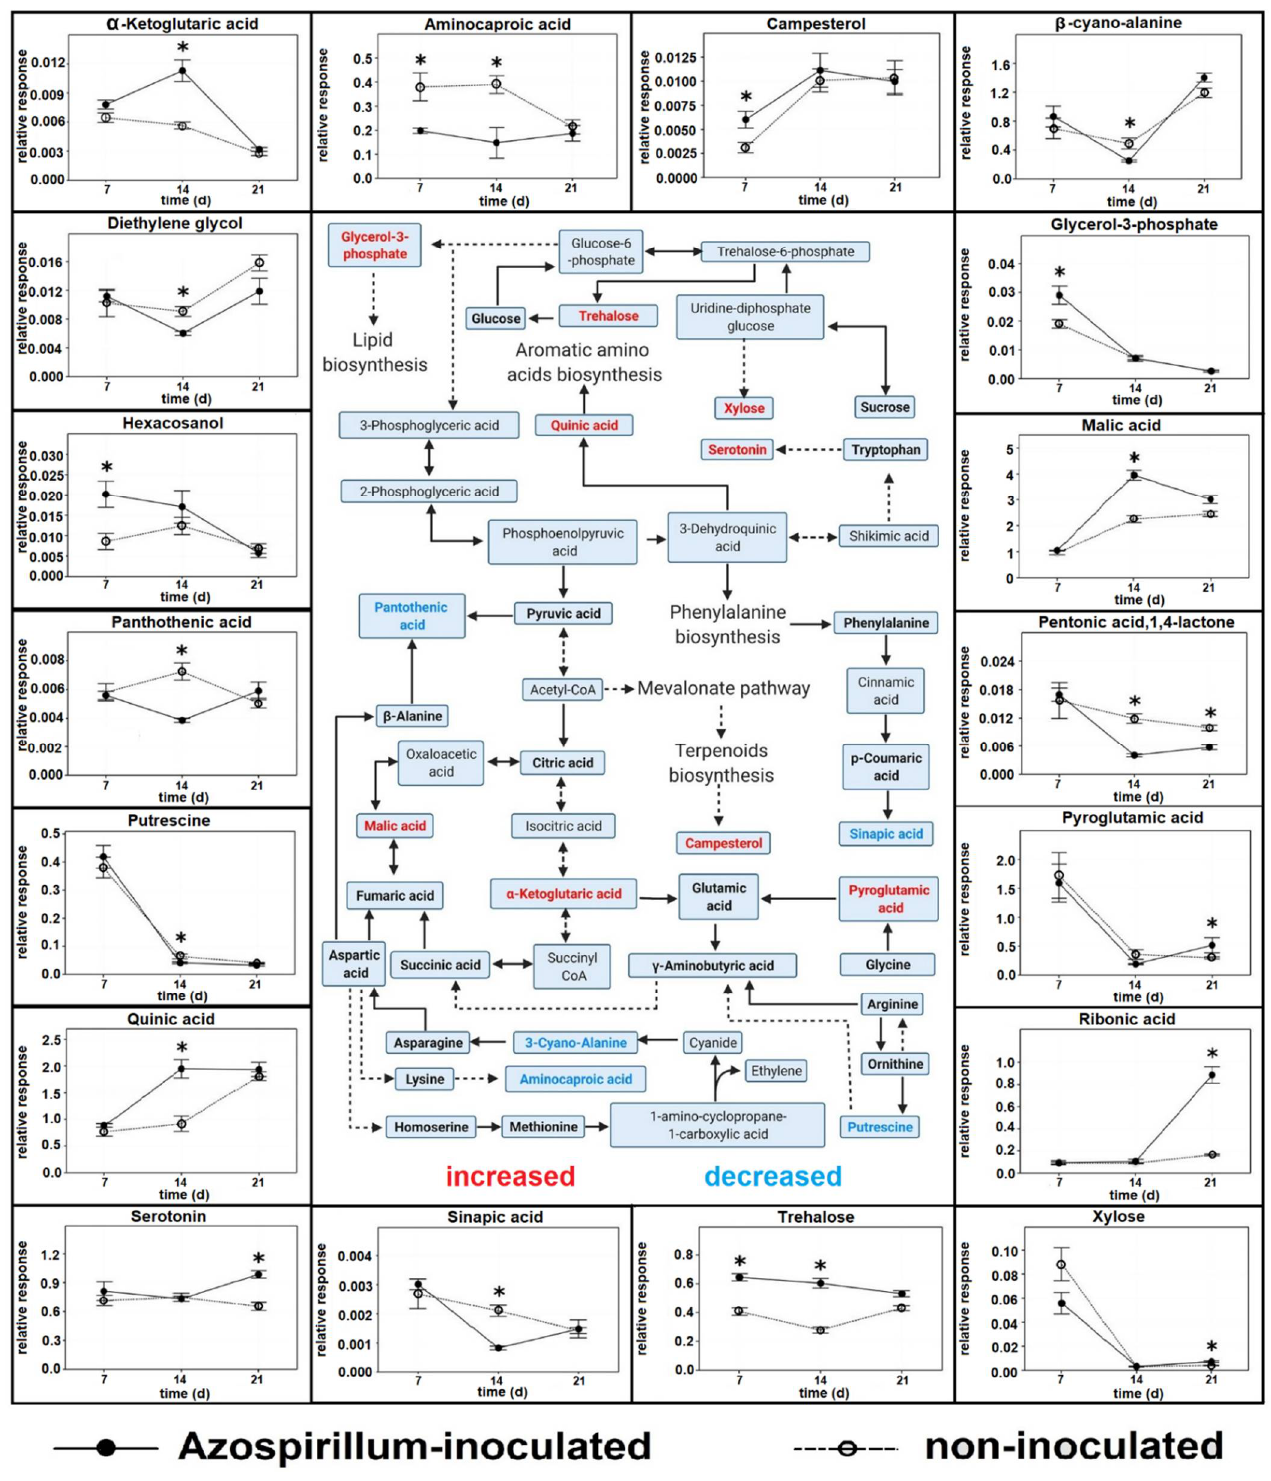
Figure 5. Mapping of the polar metabolites affected by inoculation with Azospirillum at 7, 14, or 21 DAI in relation to primary metabolism pathways. In the central diagram, detected compounds appear in bold font, and a dotted line connecting two compounds indicates that further intermediates are present. In the surrounding plots, asterisks in the graphs indicate a FC < − 1.5 or >1.5 and probability of significant difference between mean of Azospirillum-inoculated and non-inoculated plants based on Student’s t -test p < 0.05.